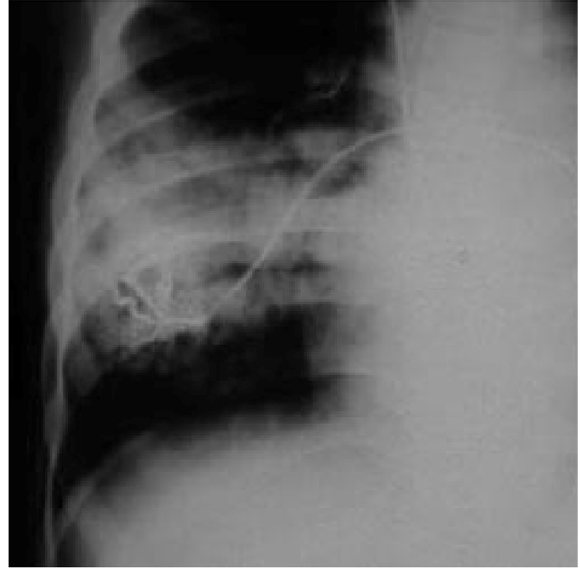
Figure 2. Contrast injection demonstrating at least three pulmonary A-V fistulae. (A-V = arteriovenous). Simple right heart catheterization was adequate to prove that Dr. El-Said’s diagnosis of AV fistula was